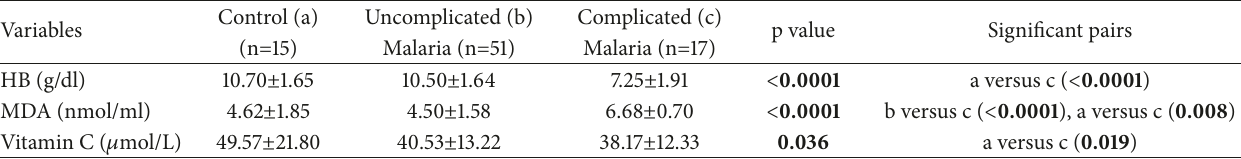
Table 4: Comparison ofhemoglobin, serum MDA, and vitamin C levels of control subjects and uncomplicated and complicated malaria.